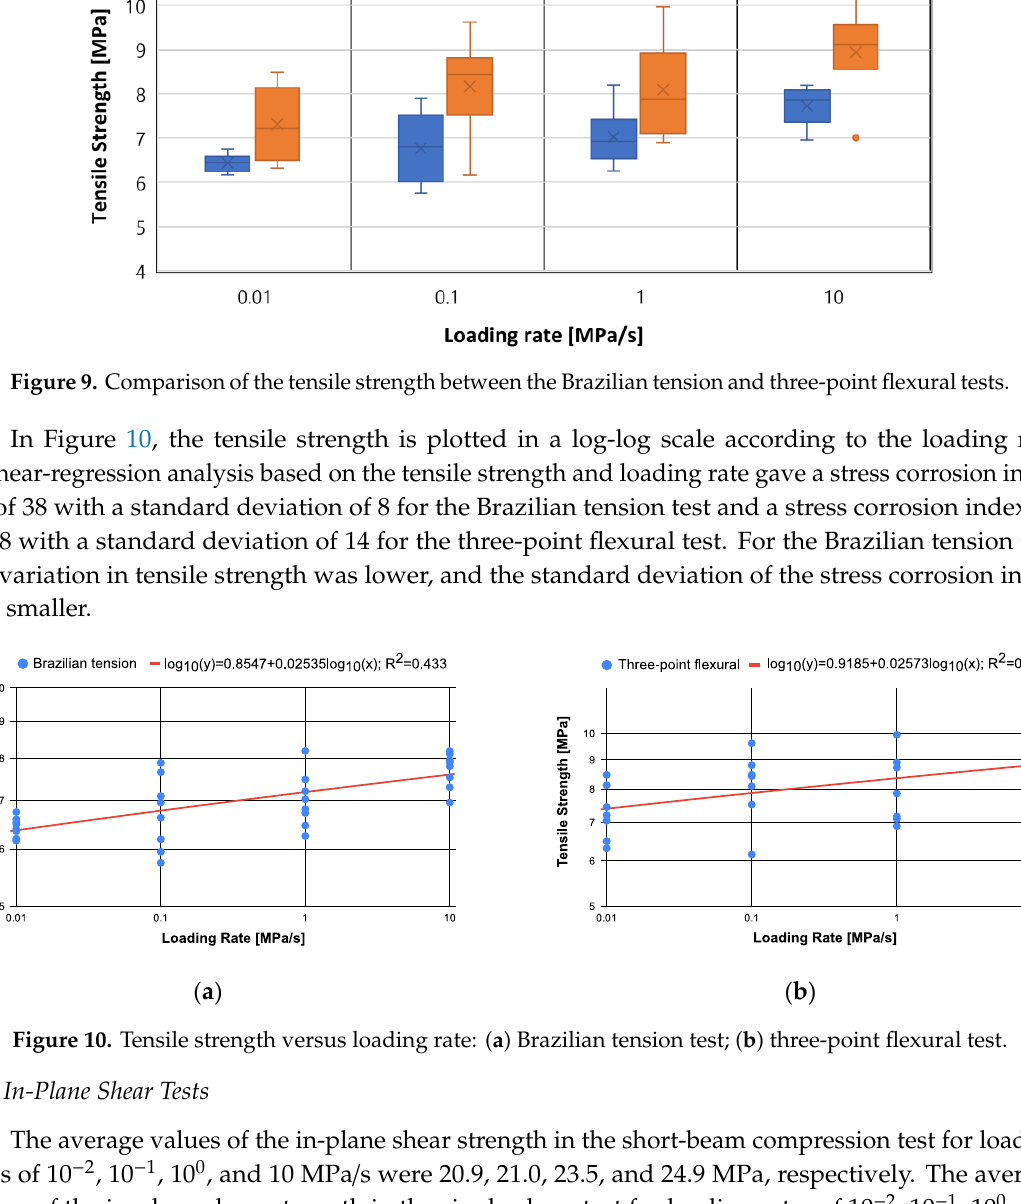
Figure 10. Tensile strength versus loading rate: ( a ) Brazilian tension test; ( b ) three-point flexural test.